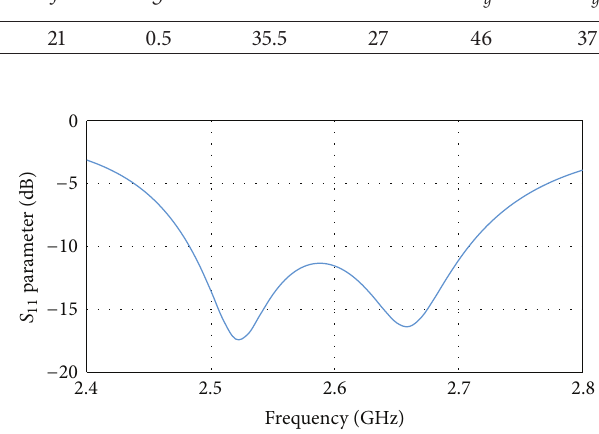
Figure 3: S -parameter of the designed 11